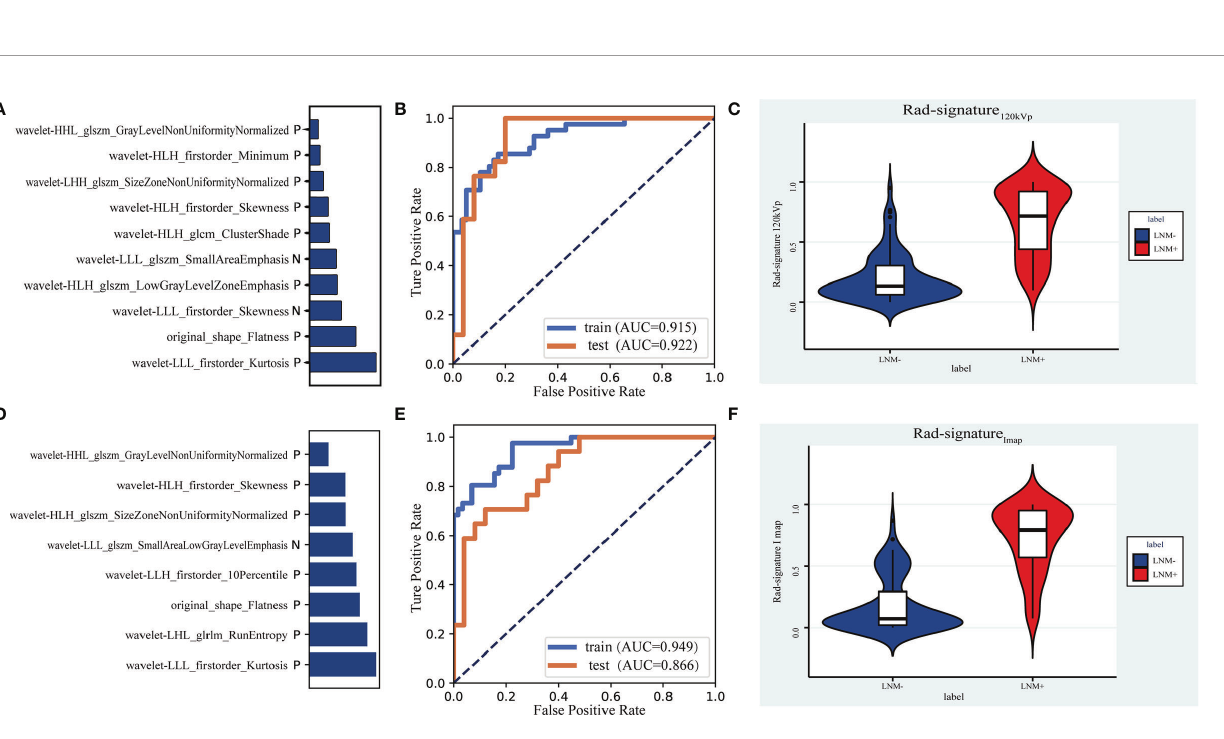
FIGURE 6 | The contribution of 10 features in the signature of 120kVp-like images (A) and the signature of iodine map (D) . Receiver operating characteristic (ROC) curves to discriminate LNM (+) from LNM (-) for the 120kvp-like radiomics model (B) and iodine map (E) radiomics model in the training and testing cohort. Violin plots of Rad-signature 120kvp (C) and Rad-signature Imap (F) to discriminate LNM (+) from LNM